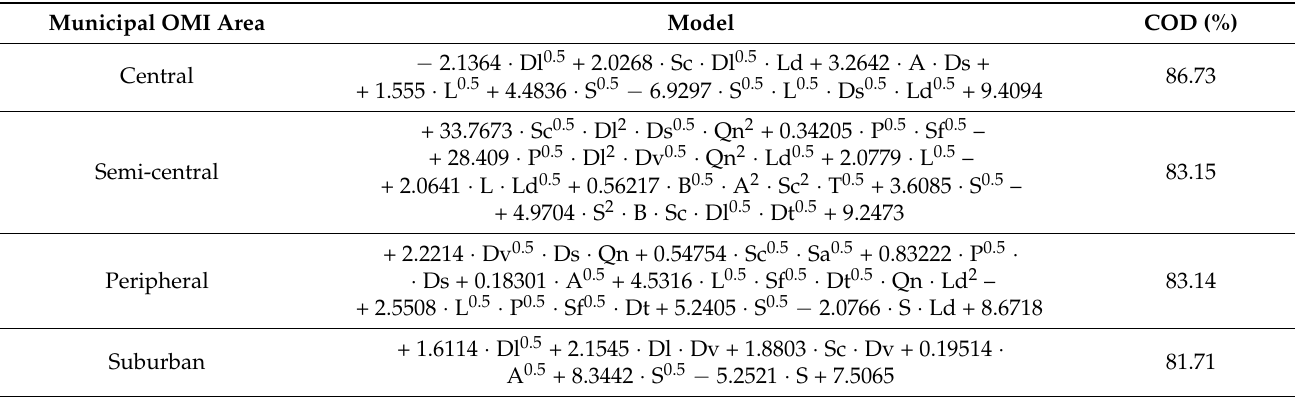
Table 2. Models generated by EPR-MOGA implementation for each municipal OMI areas of the city of Bari. Municipal OMI Area Model COD (%)